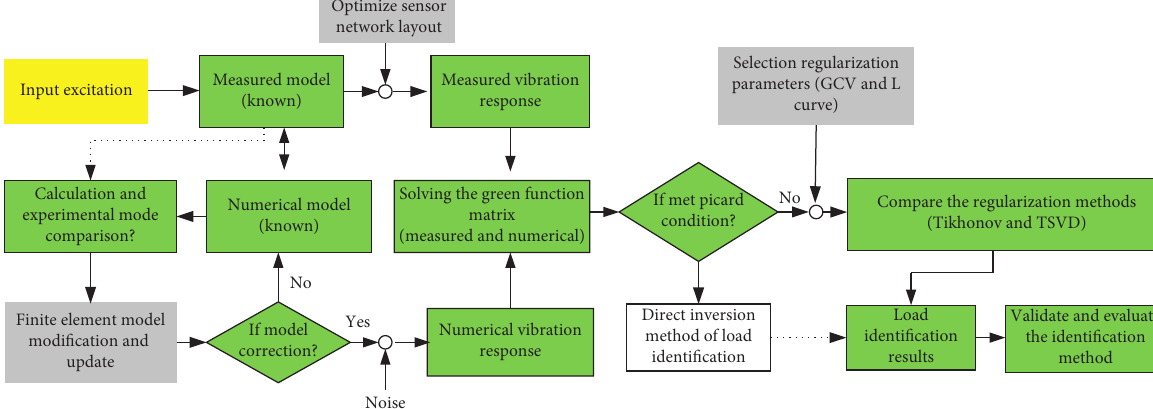
Figure 1: Load identification improved algorithm based on modified finite element model.